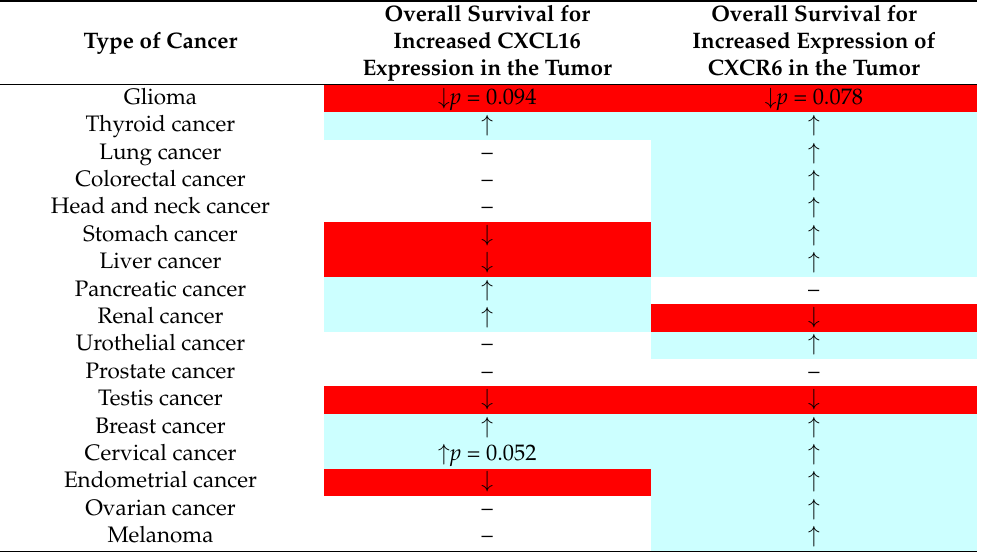
Table 4. Effect of CXCL16 or CXCR6 expression in the tumor on patient overall survival according to “The Human Protein Atlas” (https://www.proteinatlas.org, accessed on 15 January 2021) [182,183]. Type of